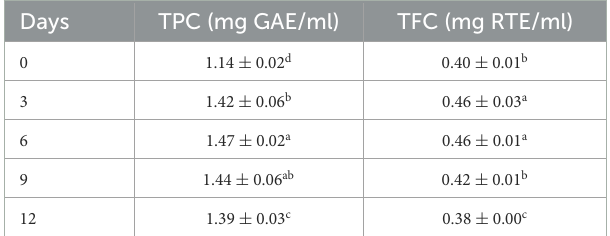
TABLE 2 Changes in TPC and TFC of Apocynum venetum L. (AVL) fermented with Aspergillus niger for 0, 3, 6, 9, and 12